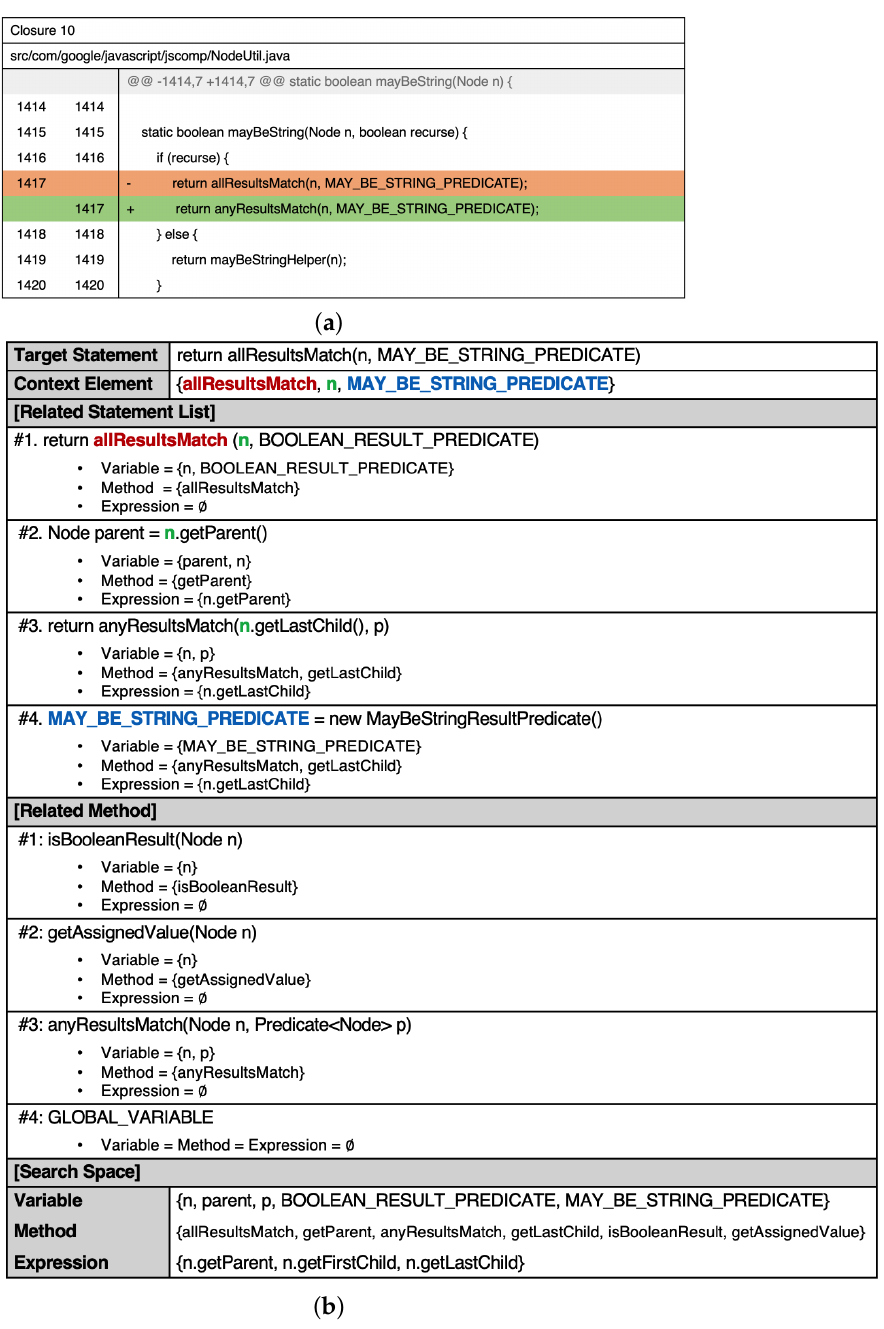
Figure 3. Concept of context and searching patch ingredient. ( a ) Developer patch of Closure-10; ( b ) Example of constructing context and extracting patch